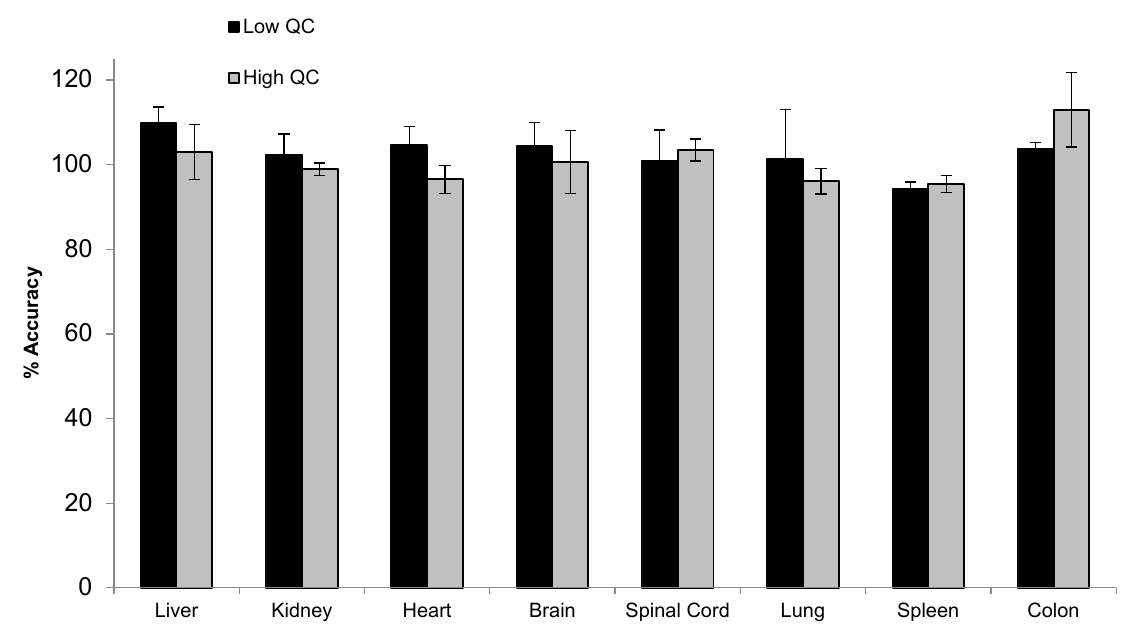
Figure 7. Accuracy and precision of siRNA-01 in monkey liver, kidney, heart, brain, spinal cord, lung, spleen, and colon homogenates (calibration curve prepared in a combined tissue homogenate).